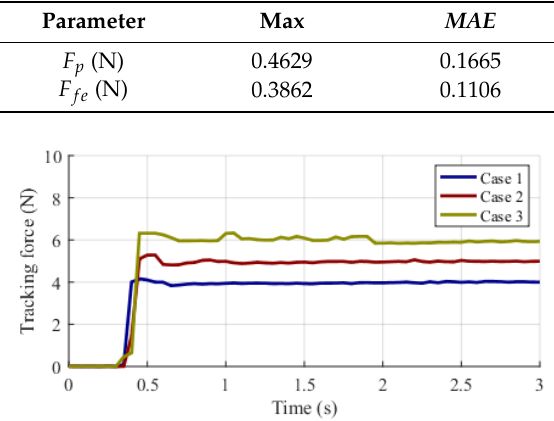
Figure 11. The force monitoring of some cases in experimental testing.